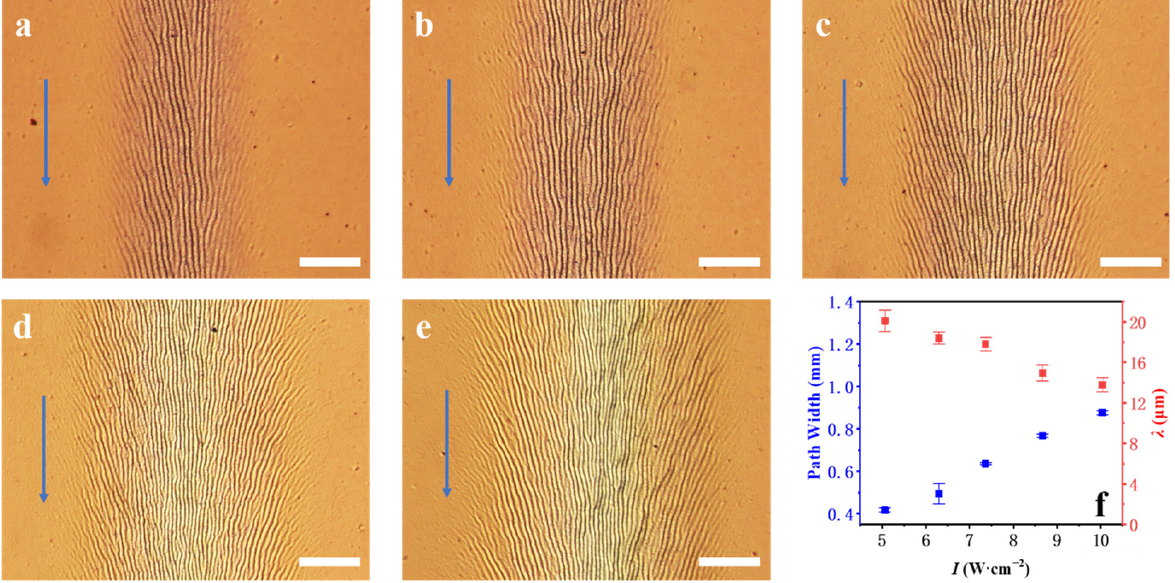
Figure 5. Optical images of wrinkles of (2% PDO 3 -1% PS)/PDMS induced by a moving laser beam (e.g., V = 1 mm·s − 1 ) on ( a ) I = 5.07 W·cm − 2 , ( b ) I = 6.30 W·cm − 2 , ( c ) I = 7.37 W·cm − 2 , ( d ) I = 8.67 W·cm − 2 , and ( e ) I = 10.04 W·cm − 2 . ( f ) The dependence of the wrinkling path width ( D ) and wavelength of the oriented wrinkles on the applied I . Scale bars: 200 μ m.